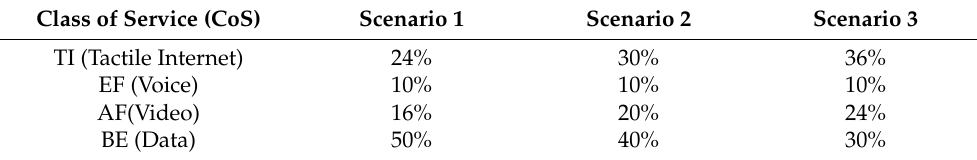
Table 5. TI-DWBA traffic